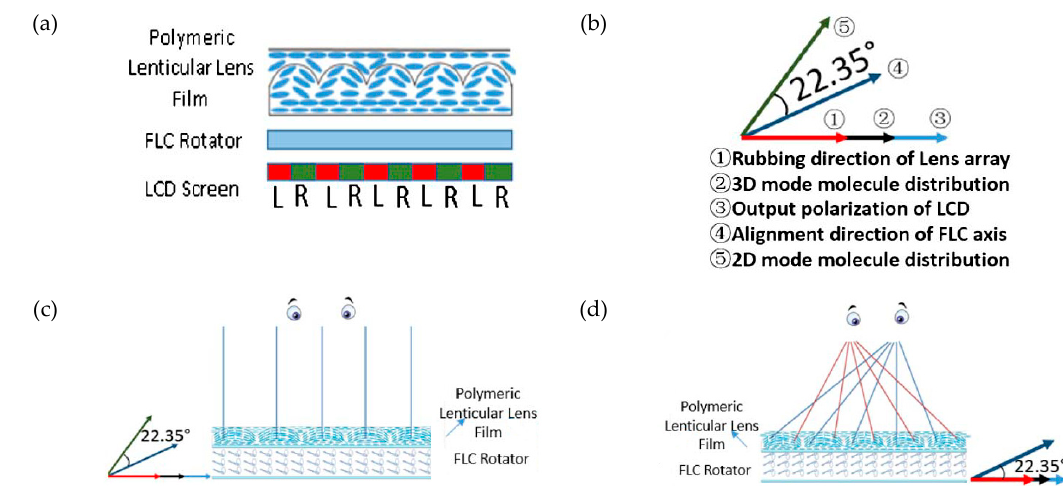
Figure 12. The operating principle of 2D / 3D switchable display. ( a ) The autostereoscopy system consists of the LC display, ESHFLC polarization selector unit, and polymeric lenticular lens array; ( b ) lens array: schematic representation of the spatial orientation. Principles of operation of ( c ) 2D and ( d ) 3D modes.